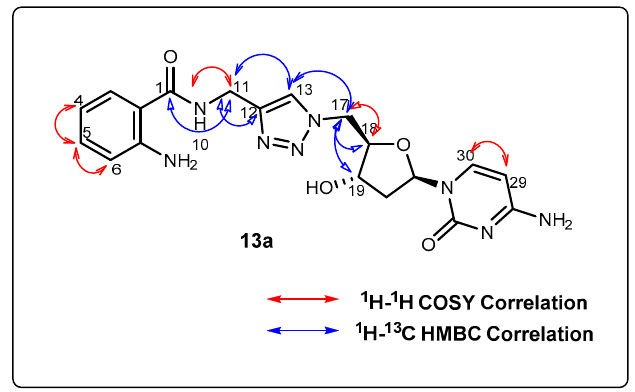
Figure 5. Key COSY and HMBC correlations in compound 13a.